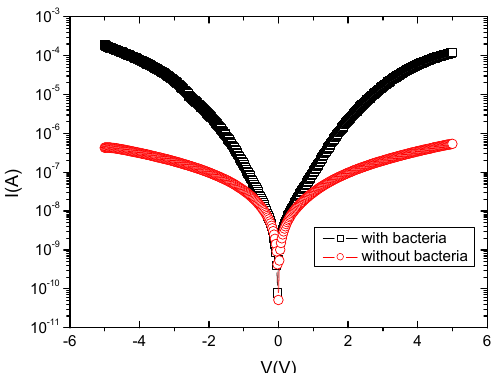
Figure 4. I-V electrical characteristics of SiNWs based resistor with and without bacteria ( Escherichia coli ATCC 35128 (concentration 8 × 10 6